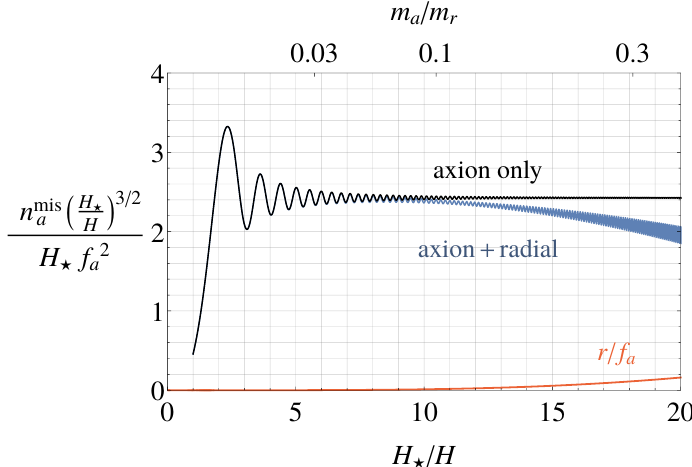
Figure 28: A comparison between the comoving axion number density from the ho- mogeneous misalignment with a ( t the full complex scalar field equations with log ( m (cid:63) of the radial mode r / ( f mode is unphysically displaced from the minimum and the axion number density is not conserved by ≈